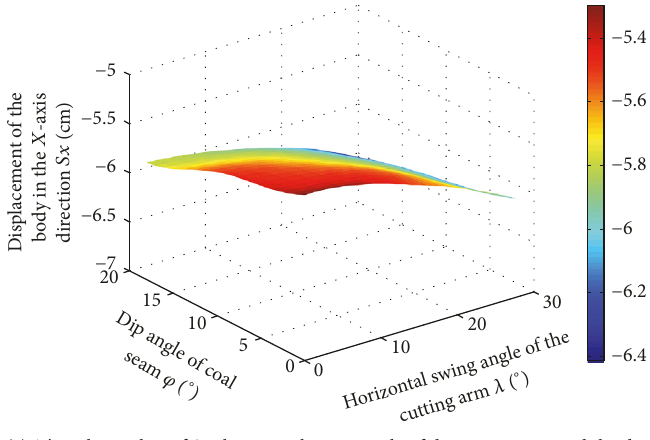
(b) The relationship between 𝑆 𝑋 and the cutting head load in different dip angles of coal seam